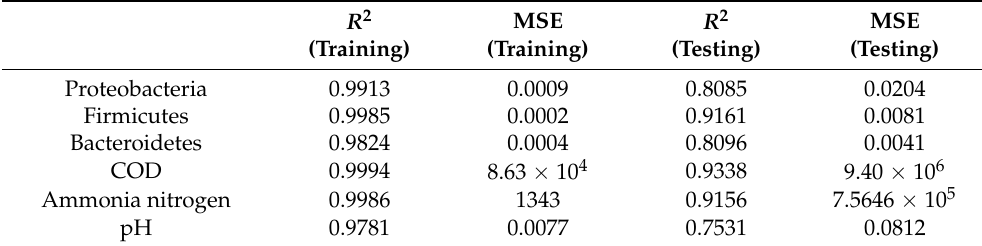
Table 11. Comparison of the GBDT prediction models based on